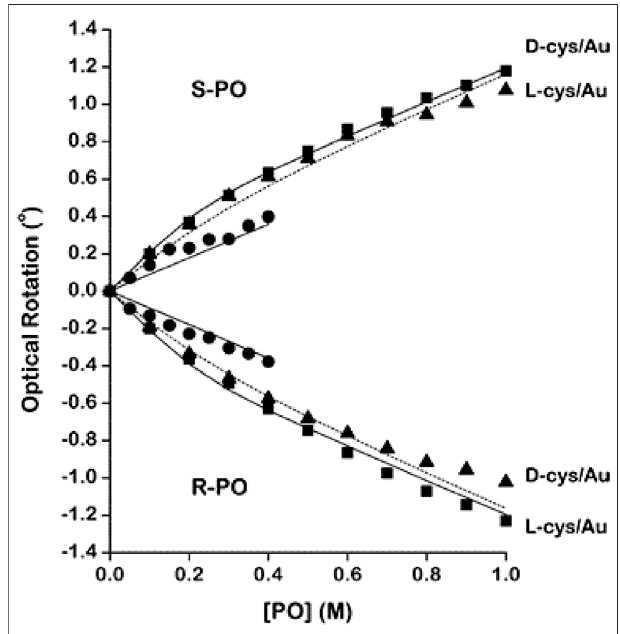
FIGURE1| Opticalrotationby( R )-and( S )-POinpureaqueoussolutions ( C ) and in solutions containing Au nanoparticles modi fi ed with D- and L-cysteine. The data from the solutions containing the heterochiral pairs (( R )- PO/L-cysand( S )-PO/D-cys) aremarkedwithsolidsquares( ■ ).Thedata from solutions containing the homochiral pairs (( R )-PO/D-cys and ( S )-PO/ L-cys)aremarkedwithsolidtriangles( ▲ ).Thesolidanddashed linesmarkthe fi ts of the adsorption model described in the text. The deviations between the data for the homochiral and the heterochiral pairs are indicative of the enantiospeci fi c interaction of ( R )- and ( S )-PO with the chiral Au nanoparticles. The fi gure and caption have been adapted with permission from Shukla et al., (2010), Copyright © 2010 American Chemical